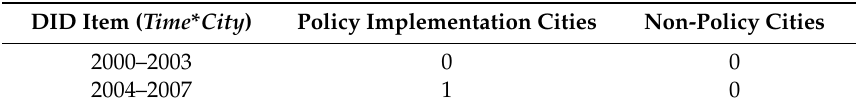
Table 10. The value of the DID item under the time point inspection.